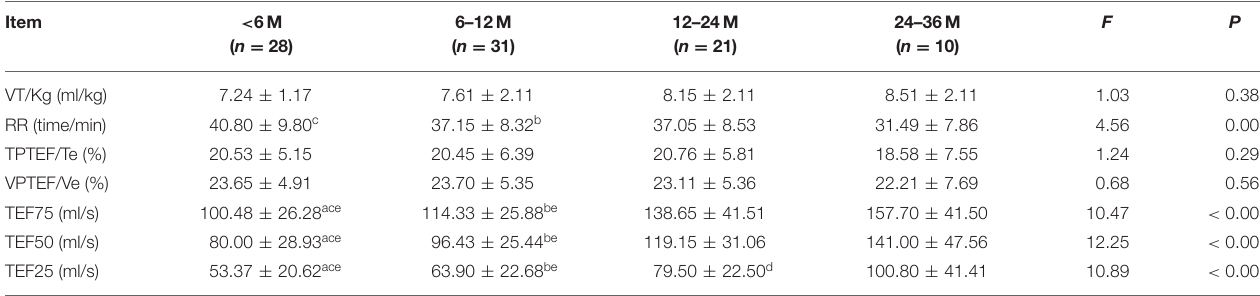
TABLE 5 | Lung function analysis in different age groups.